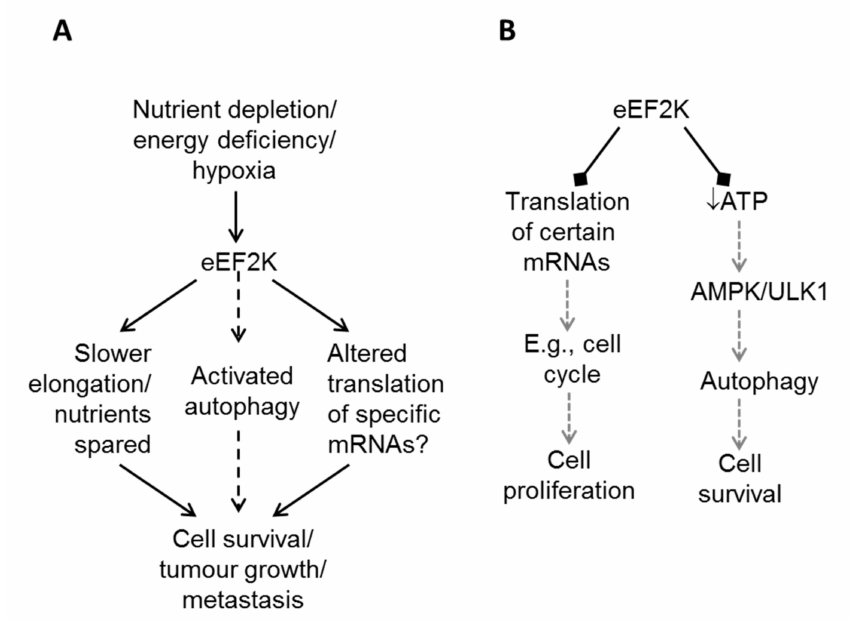
Figure 2. Roles of eEF2K in cancer cells. ( A ) In many types of tumour cells, and likely in more advanced solid tumours, eEF2K helps protect cells against nutrient depletion and other stresses by slowing down protein synthesis (thereby conserving resources) and/or altering the translation rates of specific mRNAs and thus the levels of the corresponding proteins. Some studies also suggest that eEF2K can promote autophagy, but this is not a general effect (dashed line). ( B ) eEF2K may also restrain tumour initiation, e.g., in colorectal cancer, by inhibiting general protein synthesis and/or the translation of specific mRNAs. Also, by maintaining ATP levels (through inhibition of protein synthesis), eEF2K may also indirectly inhibit the activation of